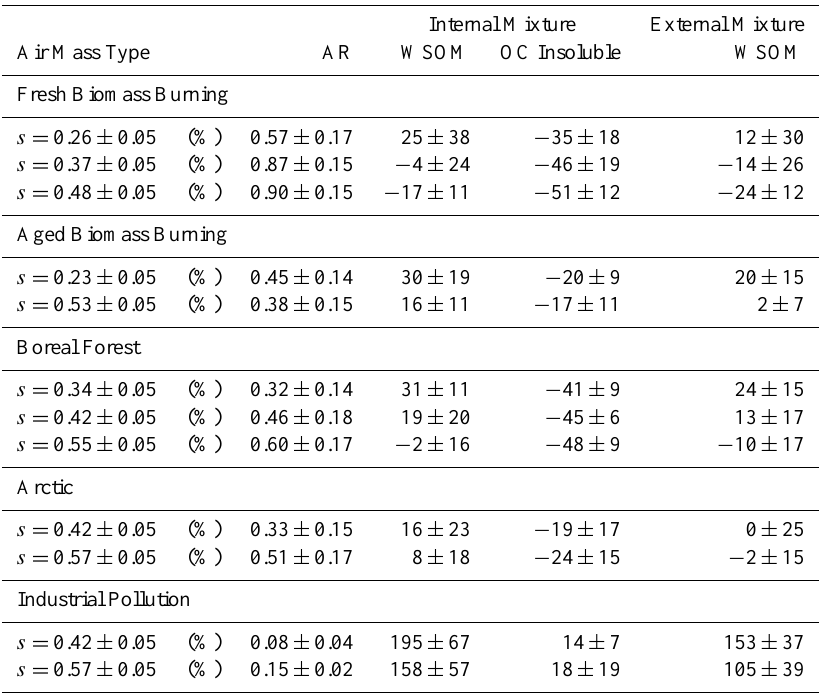
Table 2. Summary of CCN closure errors (%) for the three closure scenarios tested: (1) internally mixed aerosol with organics assumed completely insoluble with κ org = 0, (2) internally mixed aerosol with hygroscopicity of organics parameterized by κ org = 0 . 12 ε WSOM and (3) externally mixed aerosol with hygroscopicity of organics parameterized by κ org = 0 . 12 ε WSOM . Supersaturation and Activation Ratio (CCN/CN) are denoted as s and AR, respectively. Internal